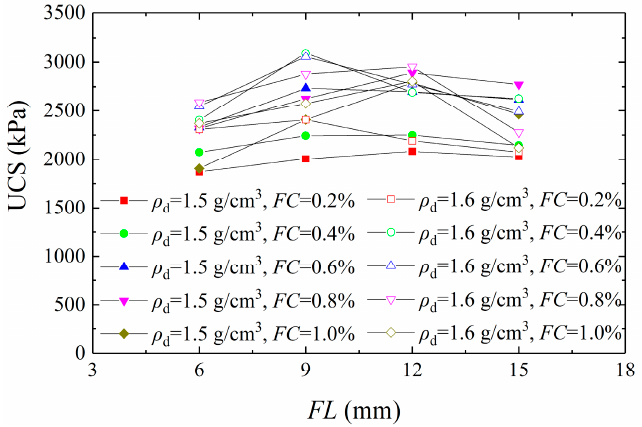
Figure 5. Curves of unconfined compressive strength versus fiber length.